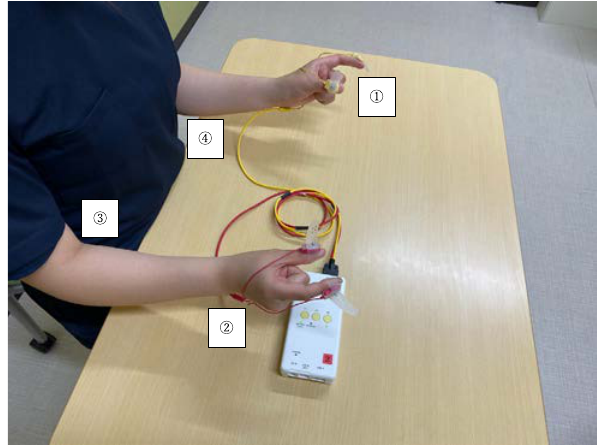
Figure 3 Points to note when measuring ① : Rest the third to fifth fingers lightly in the palm. ② : Keep the wrist joints in slight dorsiflexion. ③ : Keep the forearms in the intermediate position between pronation- supination, and the upper arms close to the body. ④ : Keep the elbow joint off the